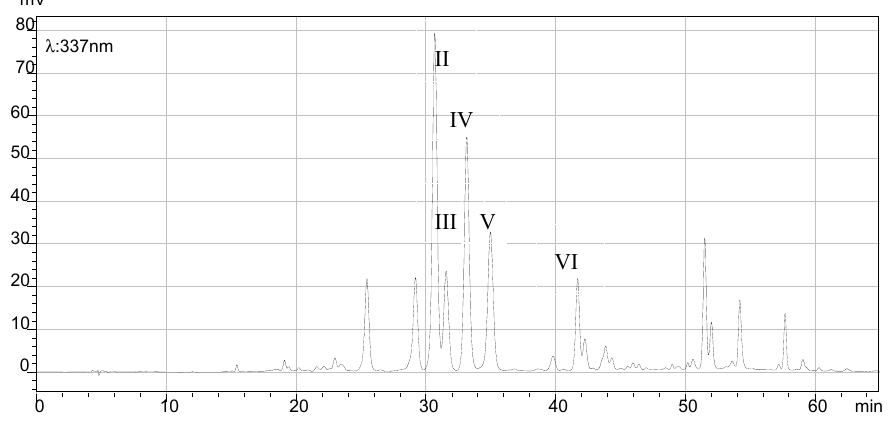
Figure 6. HPLC chromatogram of the final product ( λ = 337 nm). Comparing with Figure 5, the peak of chlorogenic acid (I) did not appeared.